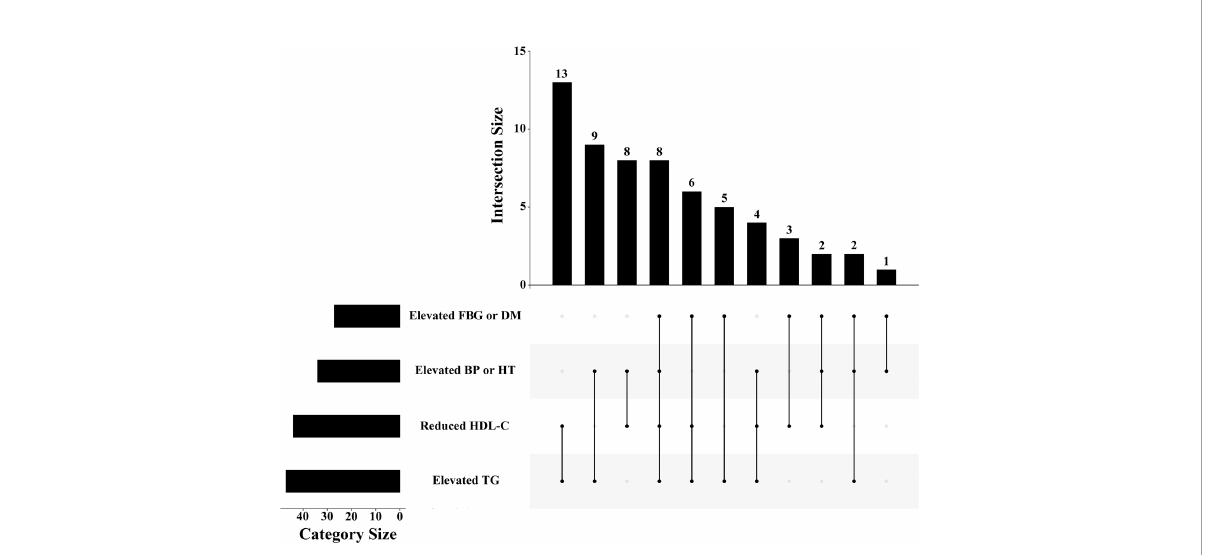
FIGURE 2 The distribution of diagnostic criteria among MetS patients in the study. FBG: fasting blood glucose; DM: diabetes mellitus; BP: blood pressure; HT: hypertension; HDL-C: high-density lipoprotein cholesterol; TG: